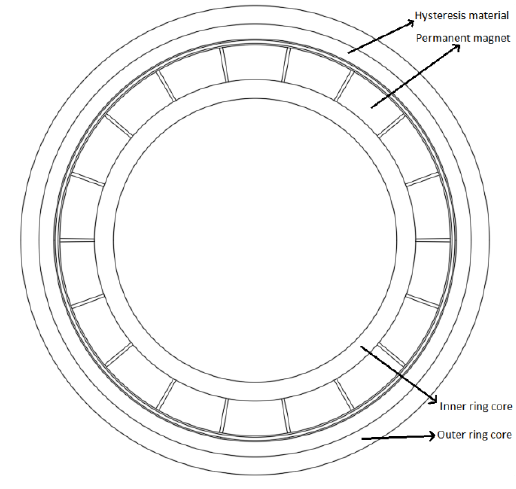
Figure 7. Hysteresis Clutch. Table 4. Machine parameters.